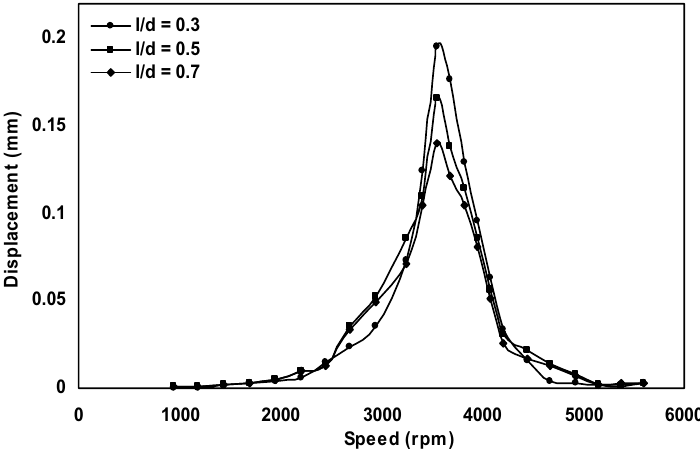
Fig. 5. L/D ratio effect on vibration amplitude (steel